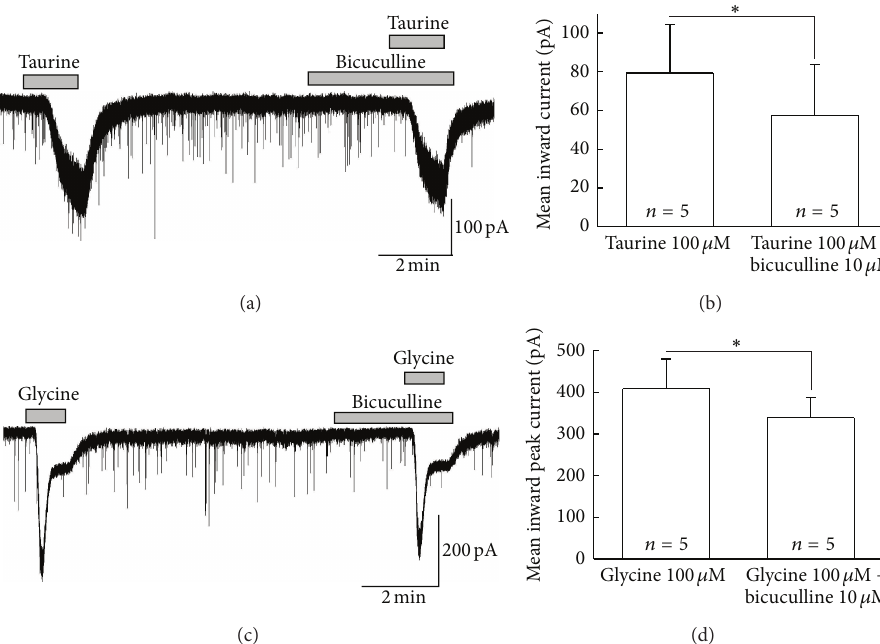
Figure 7: Sensitivity of taurine- and glycine-induced current to bicuculline. (a), (c) Currents activated by taurine and glycine were inhibited by bicuculline. (b), (d) The bar graphs show that mean inward currents effected by taurine and glycine were both reduced by the simultaneous application of bicuculline ( 𝑃 < 0.05 ) Holding potential was −